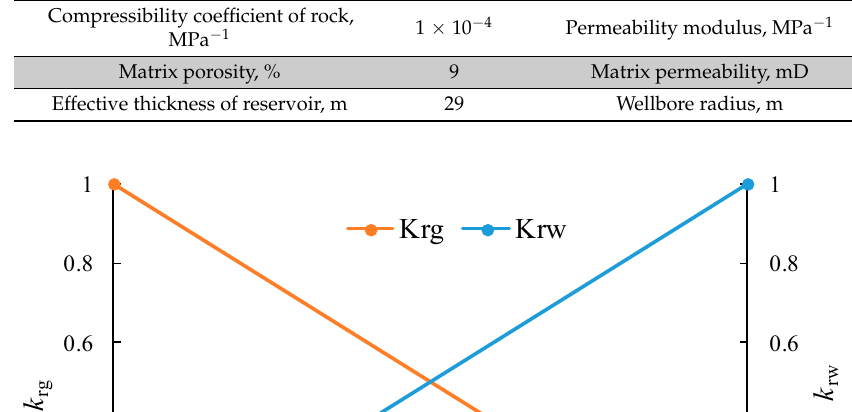
Figure 3. Relative permeability of the natural fracture system.